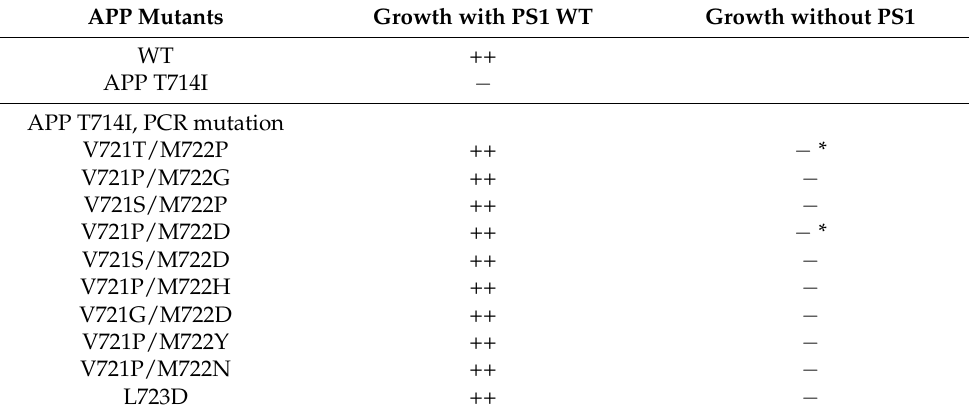
Table 1. Growth of secondary mutants that restored cleavage of the APP T714I FAD mutant. The growth of cells containing APP mutations was analyzed on SD-LWHUA media after 3 days at 30 ◦ C. All cells contained NCT, Aph-1aL-HA, and FLAG-Pen2 with or without PS1. Cells (3.0 × 10 3 ) were screened for V721/M722 mutants and 6.0 × 10 2 cells were screened for L723 mutants. Each mutant was isolated from one clone. “++” represents wild-type growth with cells forming > 1 mm colonies; “ − ” represents no growth. APP Mutants Growth with PS1 WT Growth without PS1 WT ++ APP